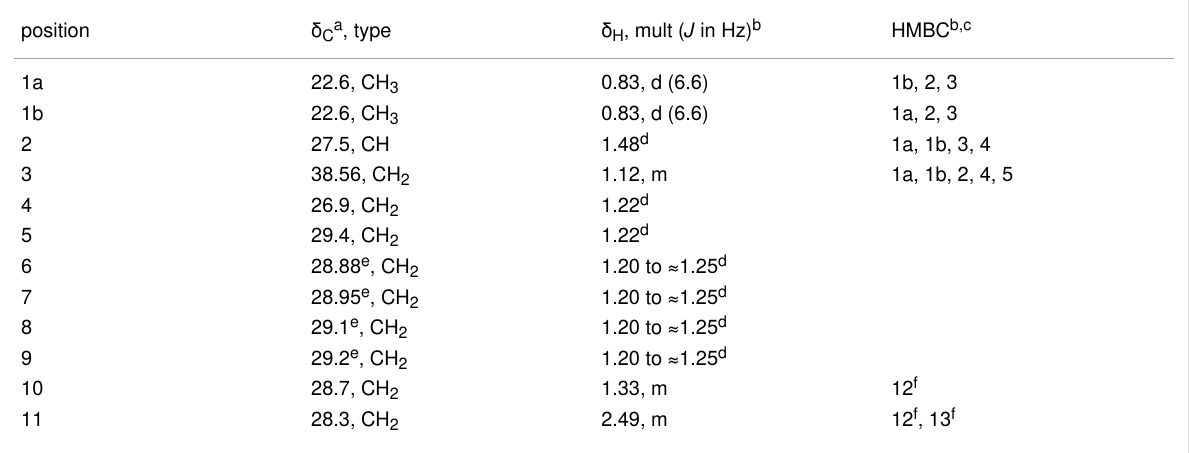
Table 1: 1 H and 13 C NMR data for tenacibactin K ( 1 ) in DMSO- d 6